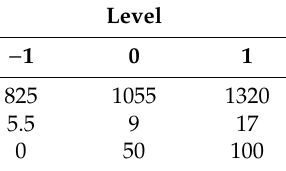
Table 3. Feasible operating limit of FSW Al–Cu.